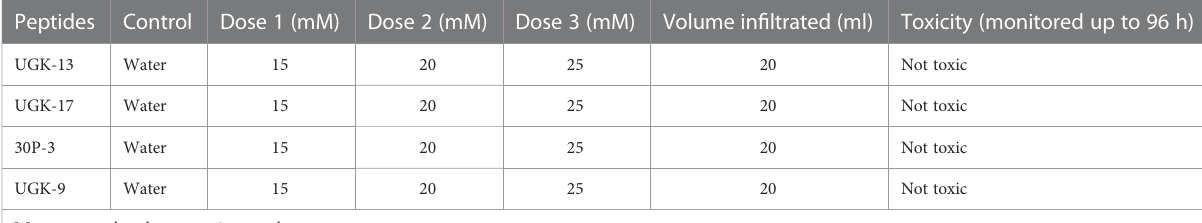
TABLE 3 Toxicity of the selected chimeras on tobacco and tomato leaves by in fi ltration of 15 – 25 mM peptide solution and the corrosive effect beyond the in fi ltration spots after 24 – 96 h. Peptides